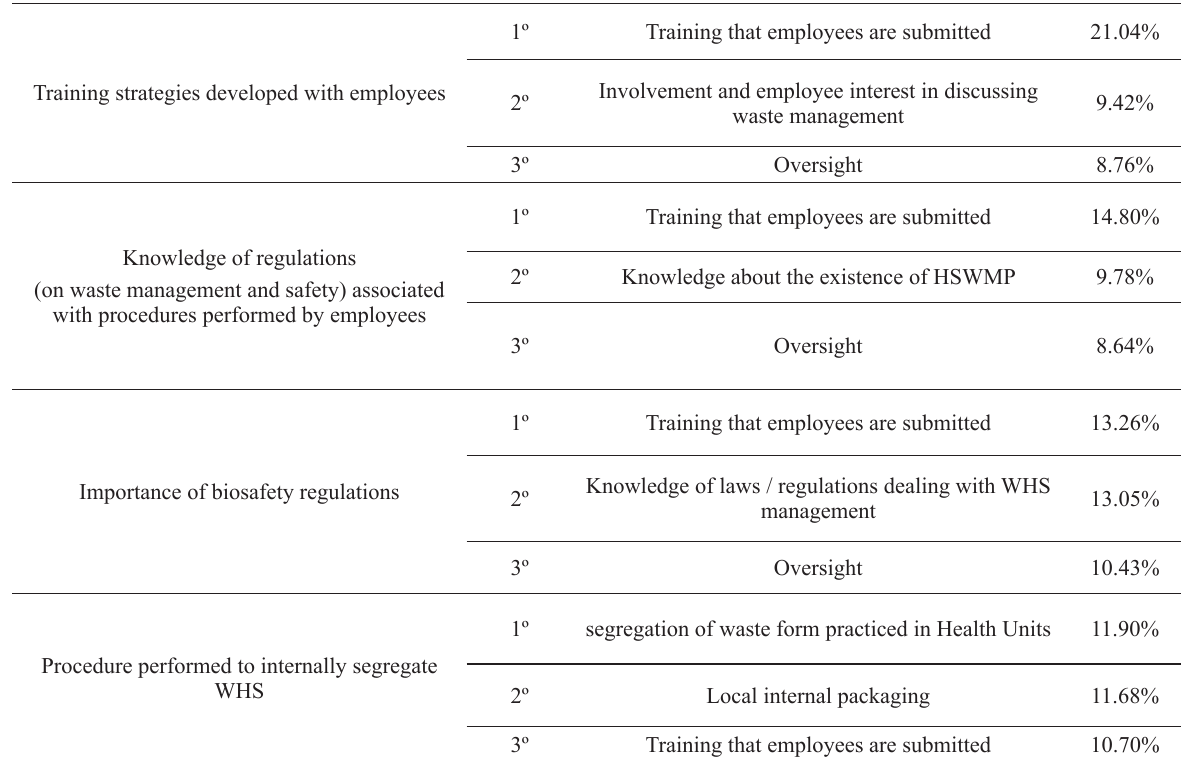
Priority Order of the alternatives according to the